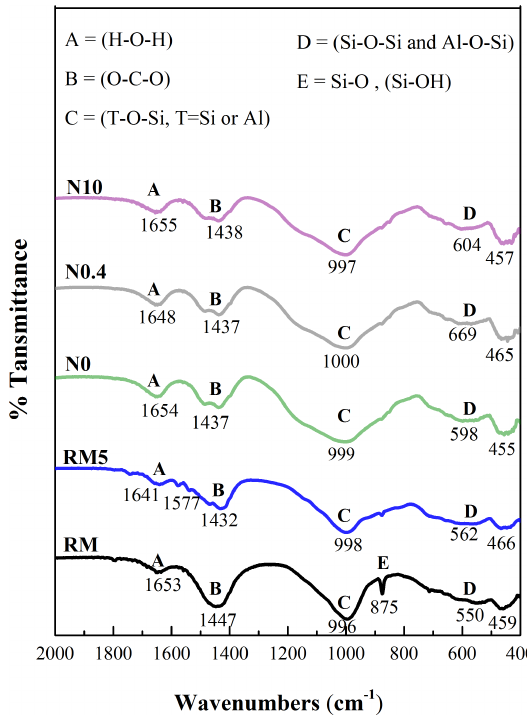
Figure 14: FTIR spectra of RM, RM5, S4.4, N0.4 and N1.0 at 28